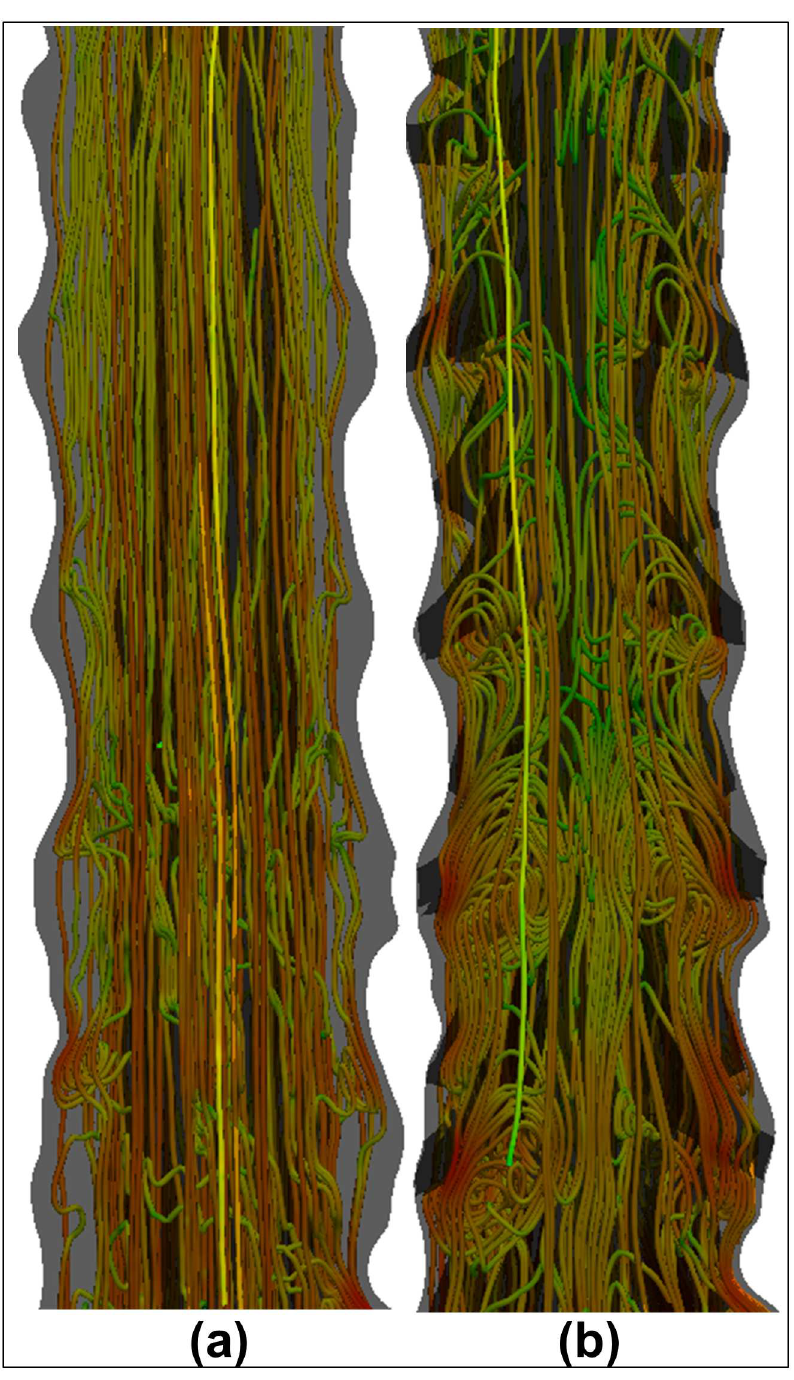
Fig 2. CSF flow streamlines at t/T = 4.5. The reportedstreamlines are obtained from test cases (a) PS ? (without NRDL) and (b) PS 1 (with NRDL).